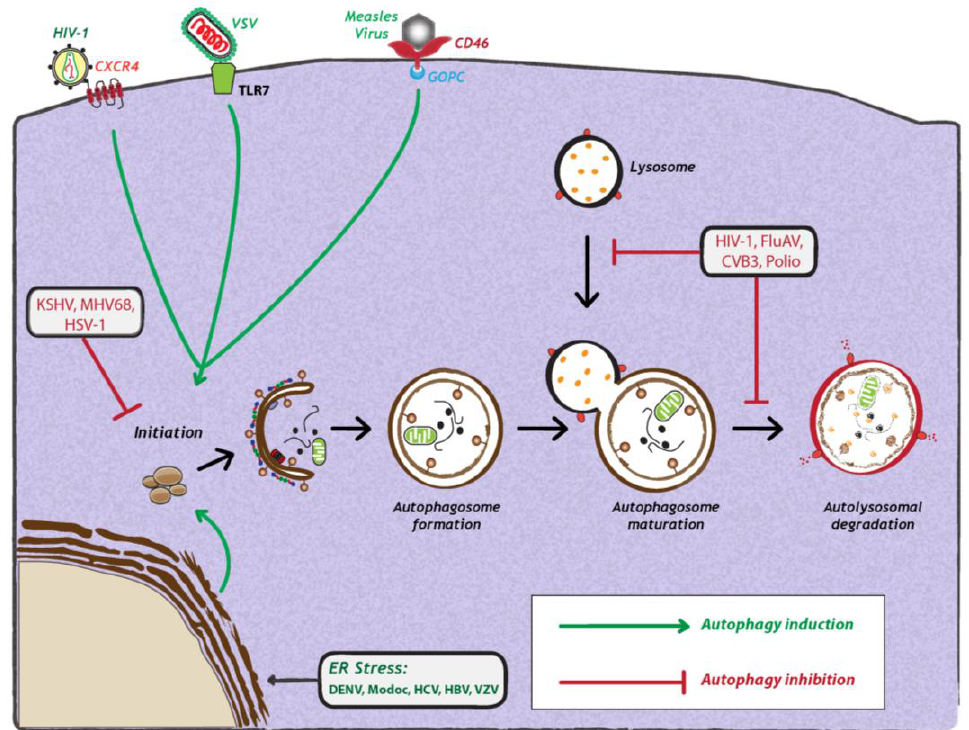
Figure 2. Viral manipulation of autophagy. Viruses can either induce (green arrows) or inhibit the autophagy pathway (red studded lines). Viral induction of autophagy can be achieved during viral entry via interaction with cell surface receptors, via interaction with stress sensors or during viral replication. Viruses also inhibit autophagy at early or late stages of the pathway, during initiation or maturation, respectively. For further details, see the legend for Figure 1. Abbreviations: HIV-1 (human immunodeficiency virus-1); CXCR4 (C-X-C chemokine receptor type 4); VSV (vesicular stomatitis virus); TLR7 (Toll-like receptor 7); CD46 (cluster of differentiation 46); GOPC (Golgi-associated PDZ and coiled-coil motif- (cid:70)(cid:82)(cid:81)(cid:87)(cid:68)(cid:76)(cid:81)(cid:76)(cid:81)(cid:74)(cid:3) (cid:83)(cid:85)(cid:82)(cid:87)(cid:72)(cid:76)(cid:81)(cid:12)(cid:30)(cid:3) (cid:46)(cid:54)(cid:43)(cid:57)(cid:3) (cid:11)(cid:46)(cid:68)(cid:83)(cid:82)(cid:86)(cid:76)(cid:182)(cid:86)(cid:3) (cid:86)(cid:68)(cid:85)(cid:70)(cid:82)(cid:80)(cid:68)(cid:3) (cid:75)(cid:72)(cid:85)(cid:83)(cid:72)(cid:86)(cid:89)(cid:76)(cid:85)(cid:88)(cid:86)(cid:12)(cid:30)(cid:3) (cid:48)(cid:43)(cid:57)(cid:25)(cid:27)(cid:3) (cid:11)(cid:80)(cid:88)(cid:85)(cid:76)(cid:81)(cid:72)(cid:3) (cid:534) -herpesvirus 68); HSV-1 (herpes simplex virus-1); FluAV (influenza A virus); CVB3 (coxsackievirus B3); DENV (dengue virus); HCV (Hepatitis C virus); HBV (Hepatitis B virus); VZV (varicella-zoster virus) ER (endoplasmic